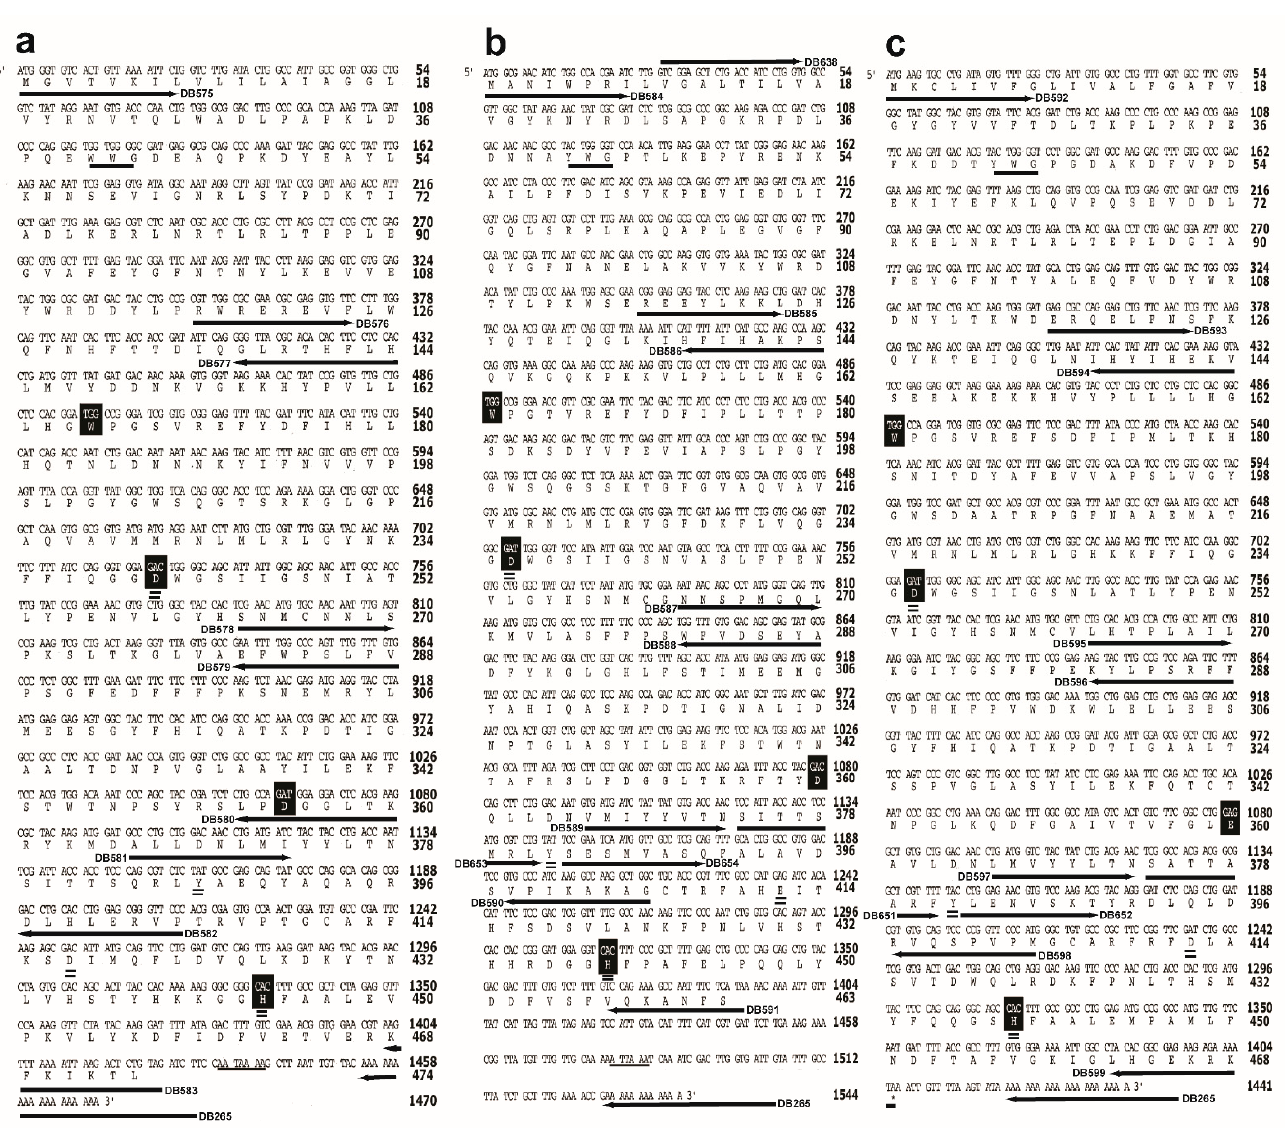
Figure 1. jheh 1, 2 and 3 cDNA cloning strategies and primers (arrows) that were used in the cloning and the sequencing. ( a ). jheh 1 cDNA amino acids and nucleotides sequence, the membrane anchor sequence WWG is single underlined, the catalytic amino acids triad DYD is double underlined, the H that participates in the catalytic activity is double underlined and the polyadenylation signal se- quence AATAAA is single underlined. ( b ). jheh 2 cDNA amino acids and nucleotides sequence, the membrane anchor sequence YWG is single underlined, the catalytic amino acids triad DYE is double nylation signal ATTAAA is single underlined. ( c ). jheh 3 cDNA amino acids and nucleotides